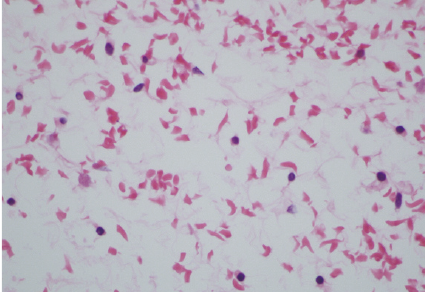
Figure 4: High power view showing sickled and tetragonal erythro-